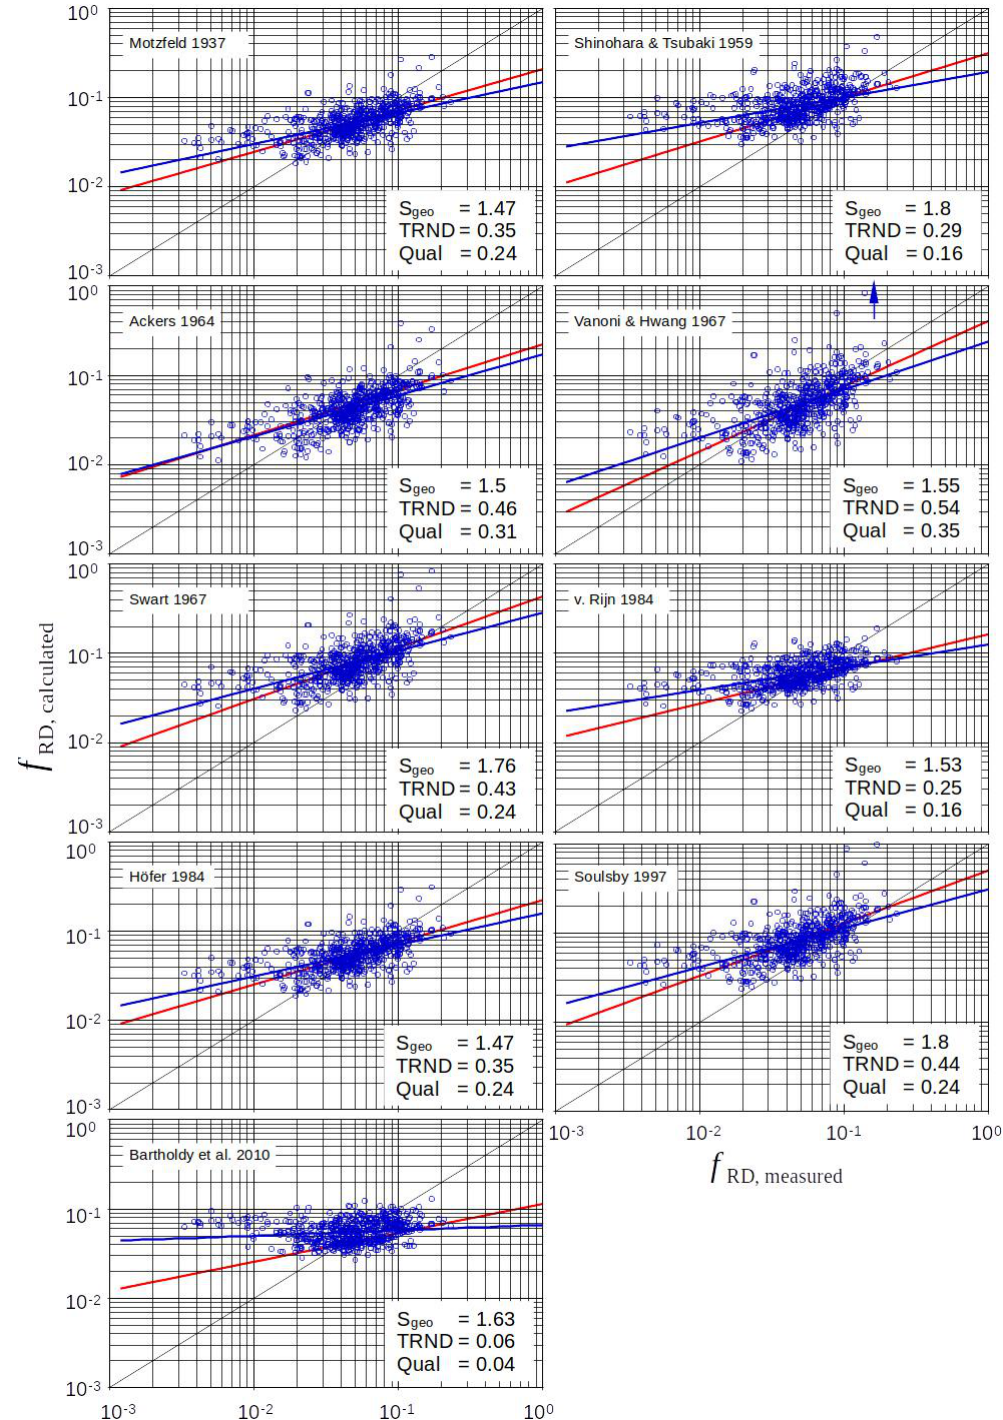
Figure 8. Approaches via the log profile f RD = 8 ( v m / v (cid:63) ) − 2 and Equation (8) in the case of ripples and dunes (red trendline: ripples, blue trendline: all data, and blue arrow = some results outside). The approach of Vanoni and Hwang 1967 [6] with a modification of κ in Equation (6) again delivers the best results in this class with respect to the general trend. However, there are some calculated results outside the